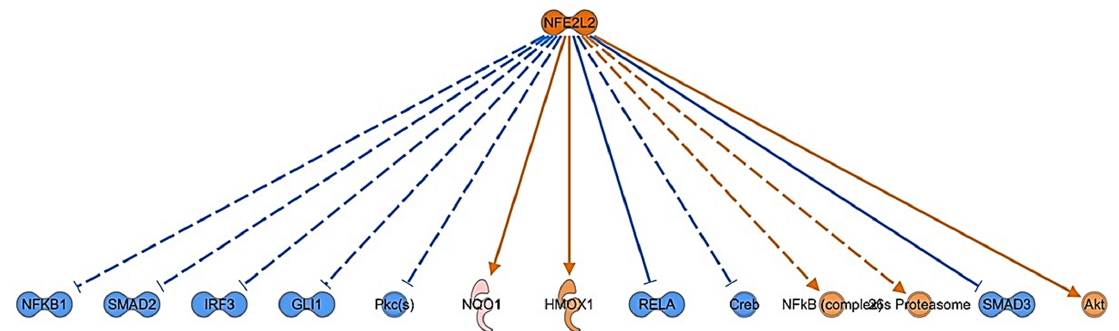
Figure 6. Computationally generated IPA causal network analysis of expanded upstream analysis, including regulators that may not be directly connected to differentially expressed proteins between Caki-1 and Caki-2 cells identi fi es NRF2 as the top hit. In addition to NRF2 activation, amongst the targets that are predicted to be activated (brown) are Akt, HMOX1, NFkB complex, and 26s pro- teasome activity. RELA and SMAD3 among others are predicted to be inhibited (blue). The pathway and network legends are identical to Figure 4.